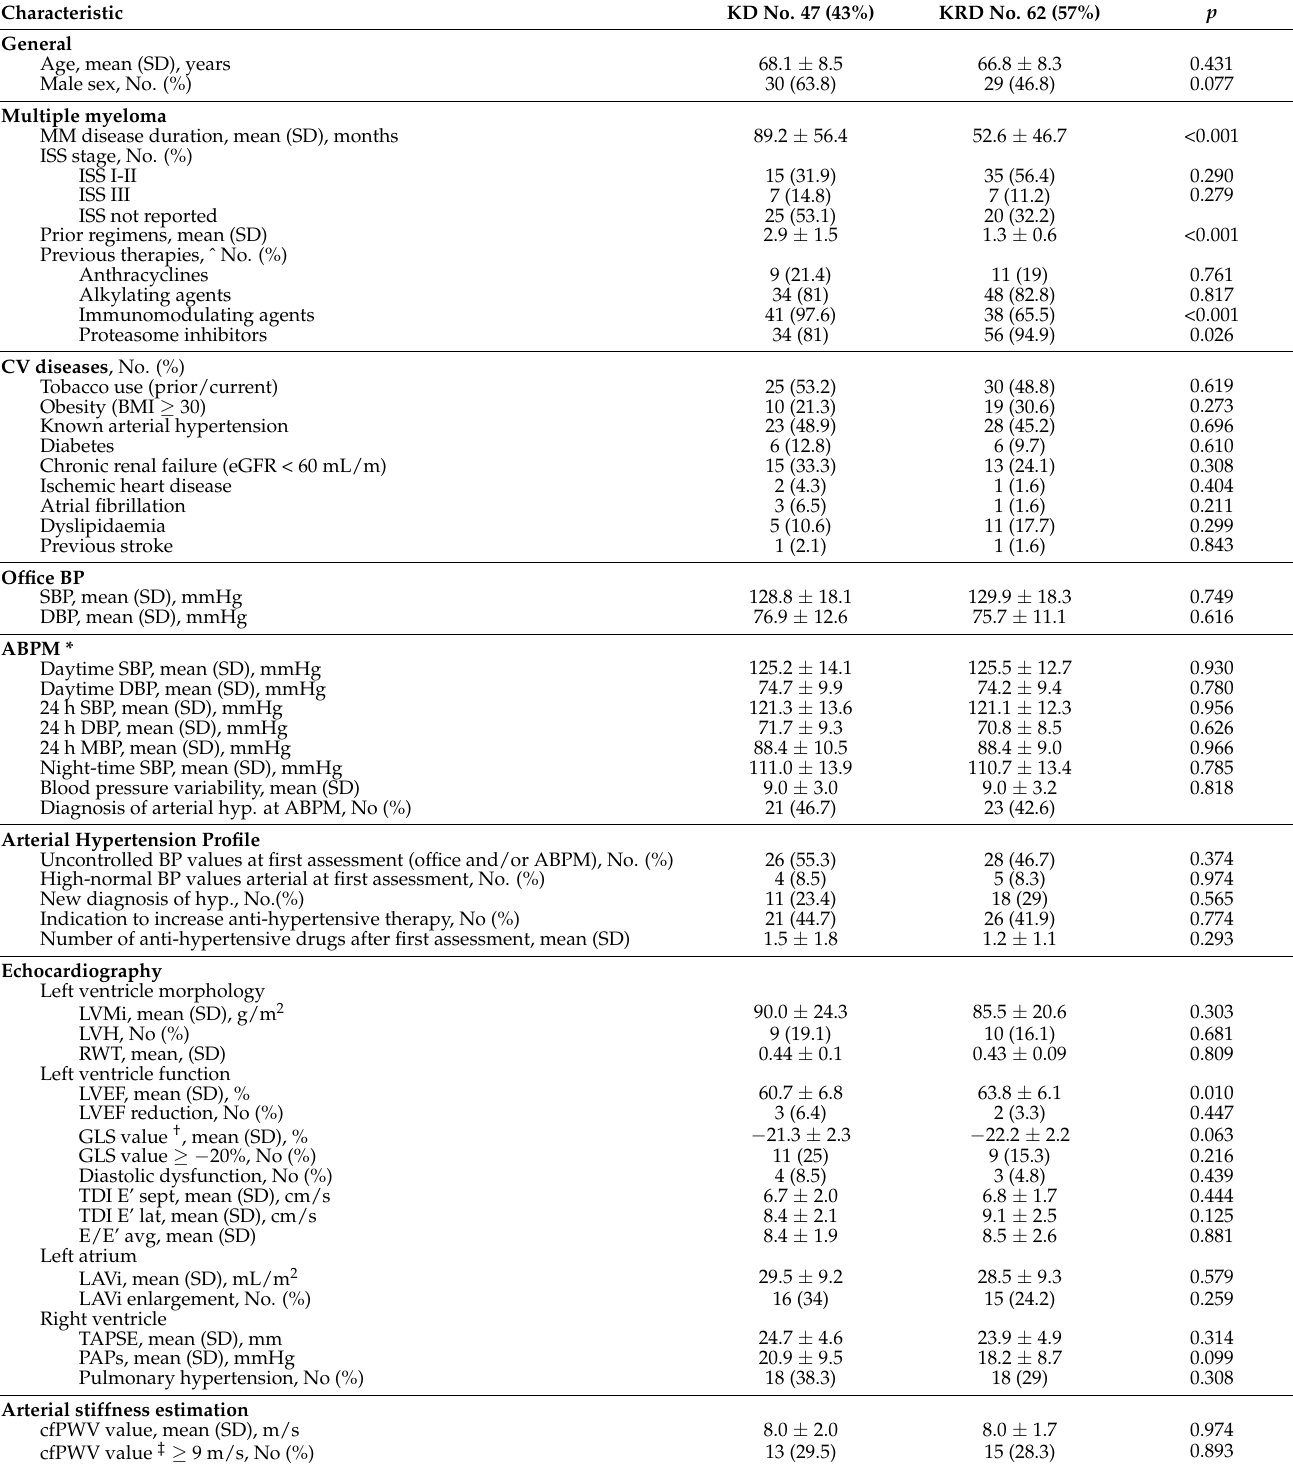
Table 1. Baseline population